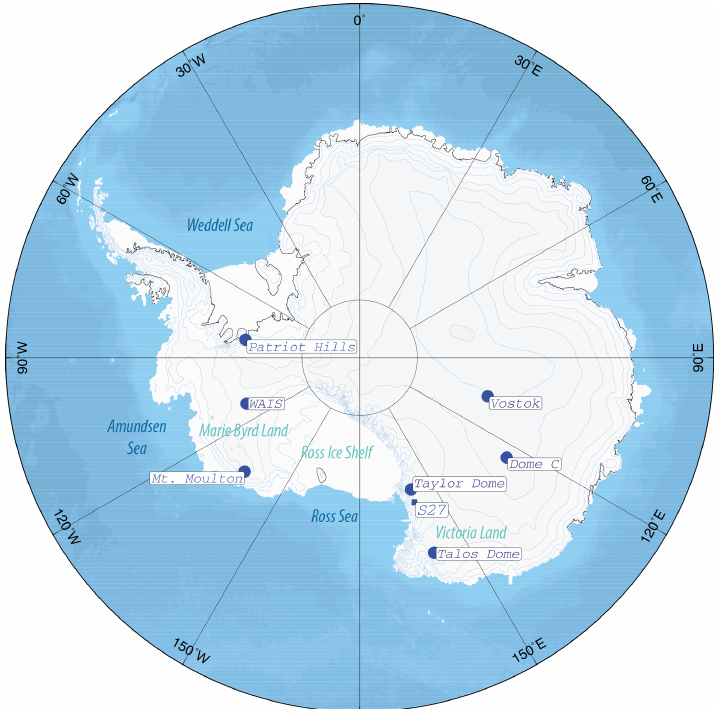
Figure 1. Locations of key ice coring sites and geographic features of Antarctica. The rectangle indicates the location of Site 27 (S27). Other ice coring sites mentioned in this study are marked with blue circles (map source: Bindschadler et al., 2011).